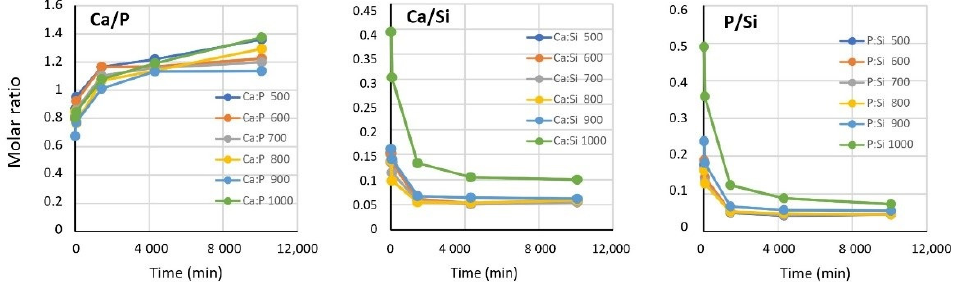
Figure 6. Molar ratios of the dissolved ionic species as a function of leaching time.